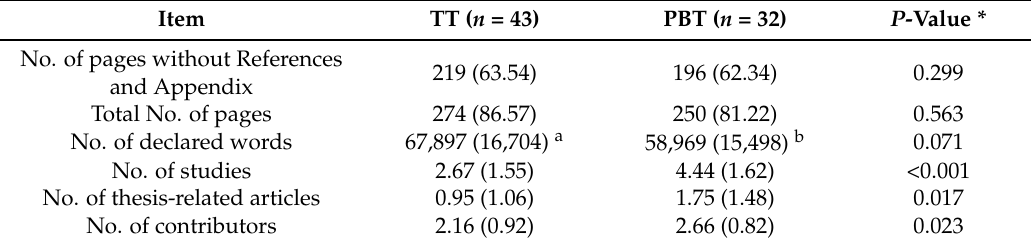
Table 2. Aspects regarding traditional and publication-based theses express as mean (standard